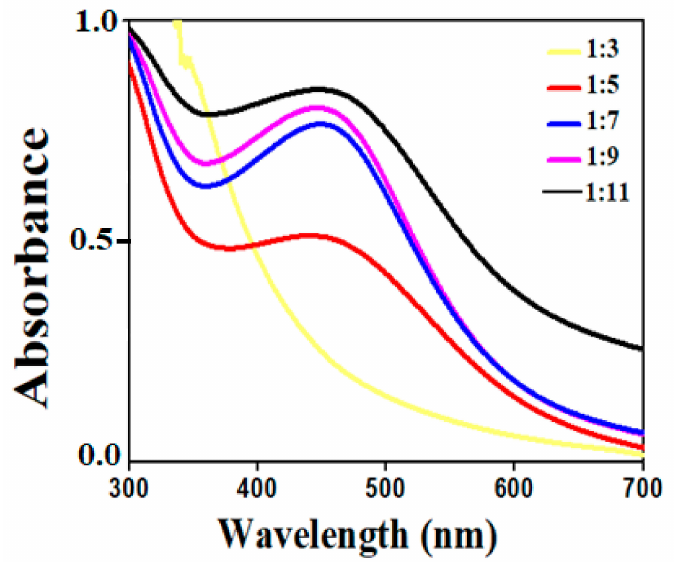
Figure 3. Effect of AgNO 3 volume to S. procumbens plant extract